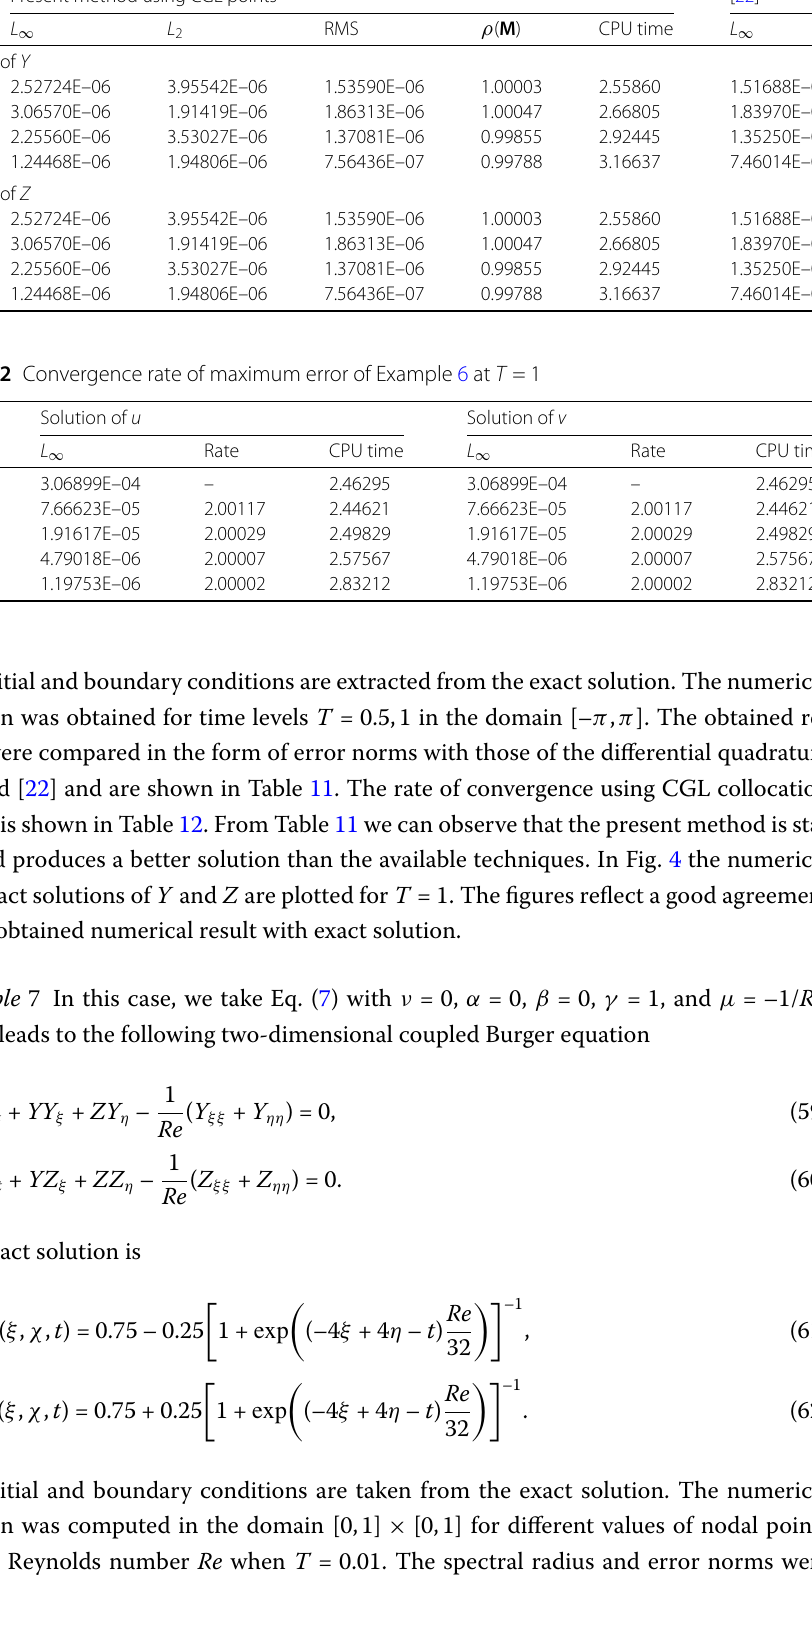
Table 11 Error norms and spectral radius for Y ( ξ , t ) and Z ( ξ , t ) of Example 6 for dt = 0.001 T Present method using CGL points [22] L ∞ L 2 RMS ρ ( M ) CPU time L ∞ solution of Y 0.5